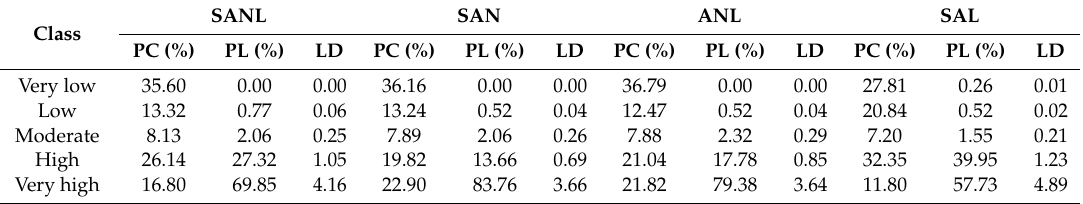
Table 3. Landslide density analysis on landslide susceptibility maps. LD: landslide density; PC: percentage of pixels in a susceptibility class; PL: percentage of landslide pixels.